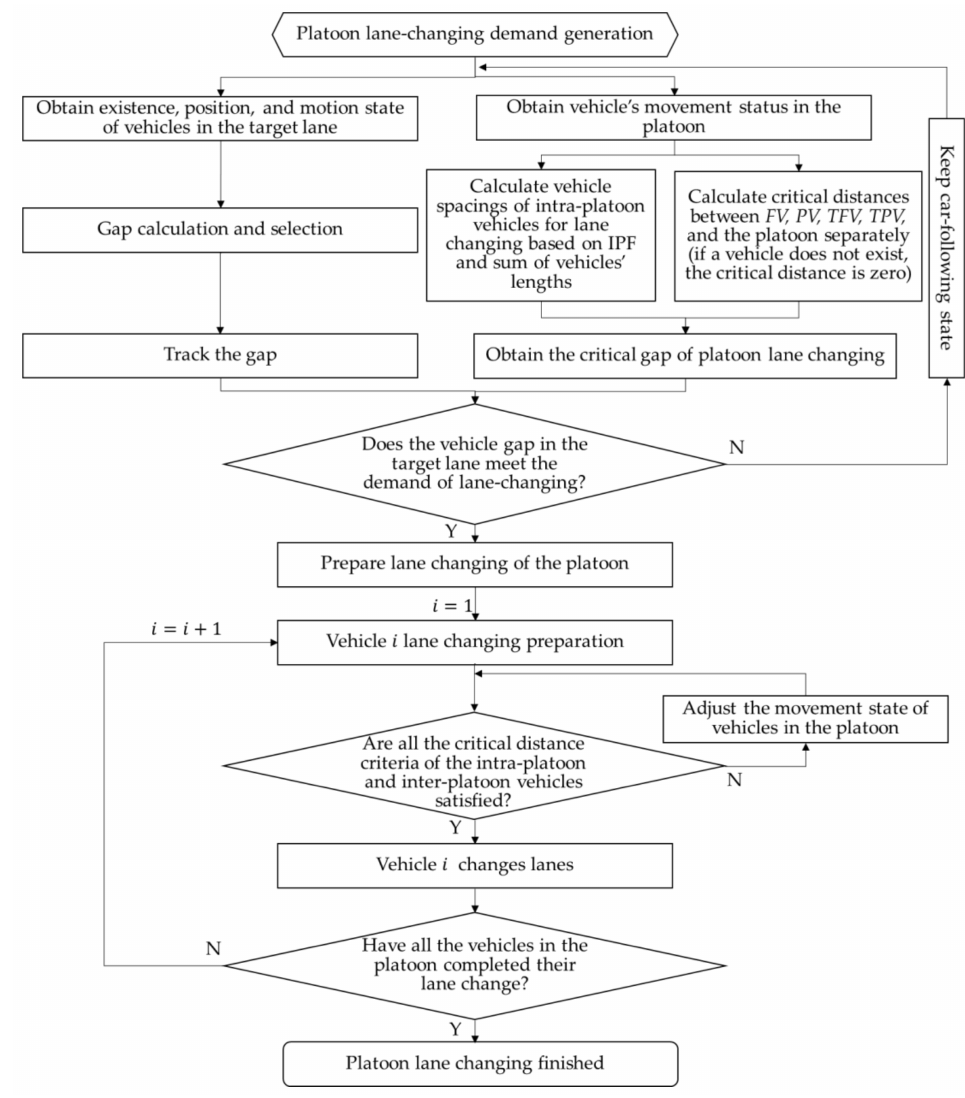
Figure 4. Flow chart of the platoon lane-changing